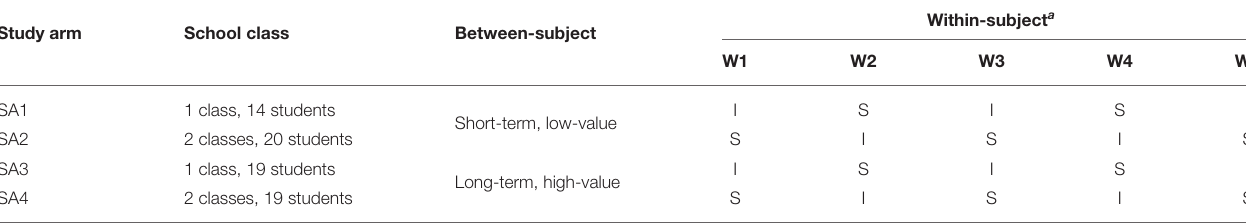
TABLE 1 | Overview of study arms and treatment allocation per school class. Study arm